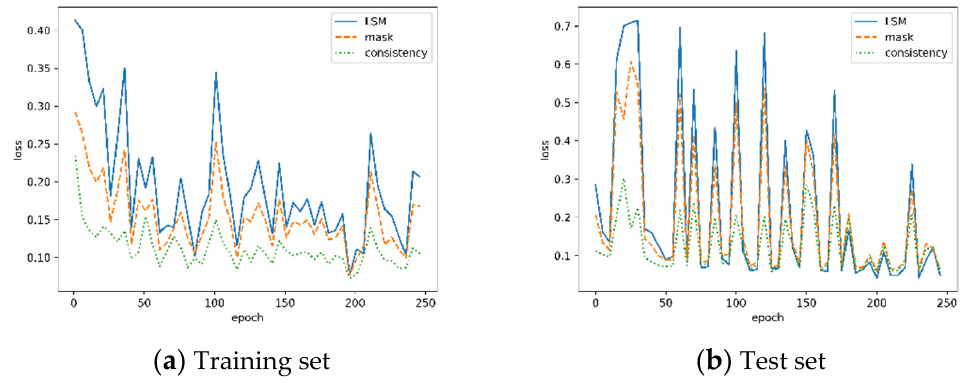
Figure 9. Training loss curves of LSMNet on the OCIS dataset.